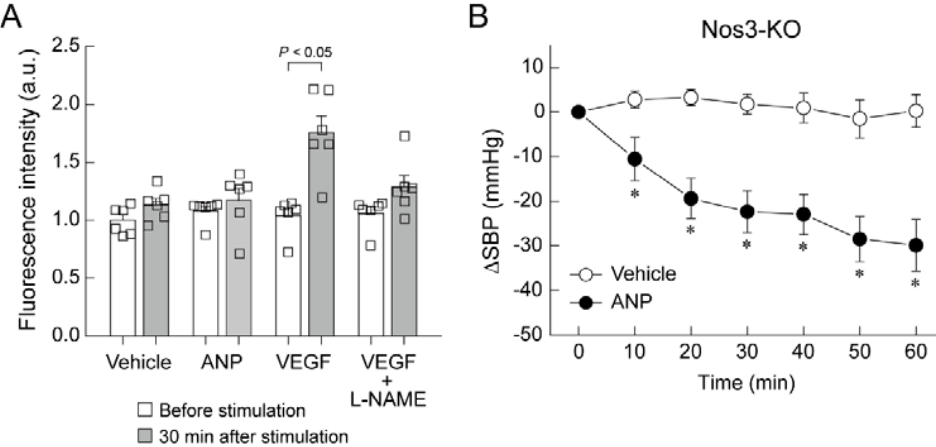
Figure 4. ANP ‐ induced hypotension is independent of nitric oxide. ( A ) The measurement of nitric oxide in human umbilical vein endothelial cells (HUVECs). HUVECs were loaded with DAF ‐ 2 DA (a fluorescent nitric oxide probe) and then treated with vehicle (PBS), ANP, VEGF, or VEGF + L ‐ NAME. Nitric oxide production was measured as cellular fluorescence (arbitrary units). Values are expressed relative to the fluorescence intensity before vehicle treatment. ( B ) Intravenous infusion of ANP (10 μ g/kg/min) significantly lowered systolic blood pressure (SBP) compared with the admin ‐ istration of vehicle (saline) in Nos3 ‐ knockout mice (Nos3 ‐ KO). * p < 0.05 vs. vehicle. This figure is a reconstruction of the figure from our original article [37].